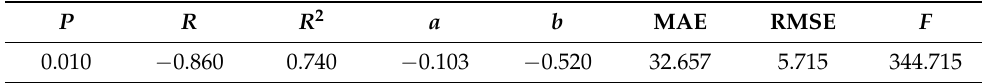
Table 1. The estimated model test